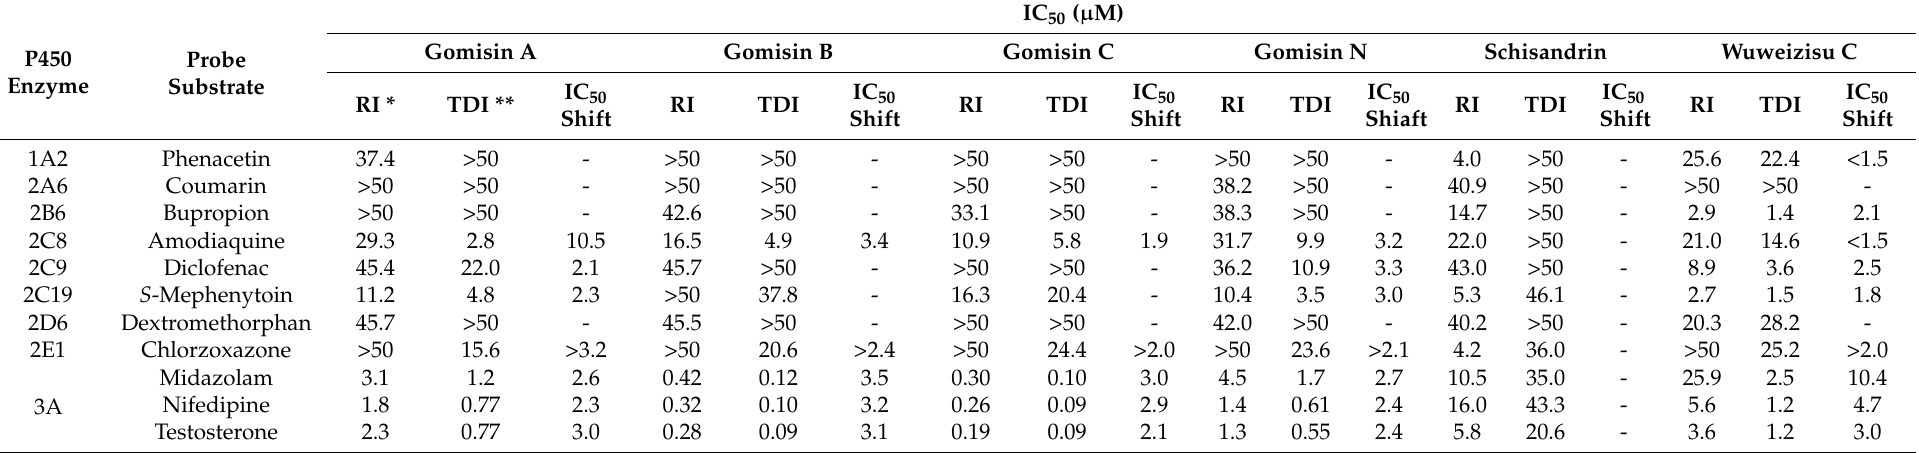
Table 3. Inhibitory effects of six lignans against nine cytochrome P450 enzymes. All incubations were performed in triplicate ( n =